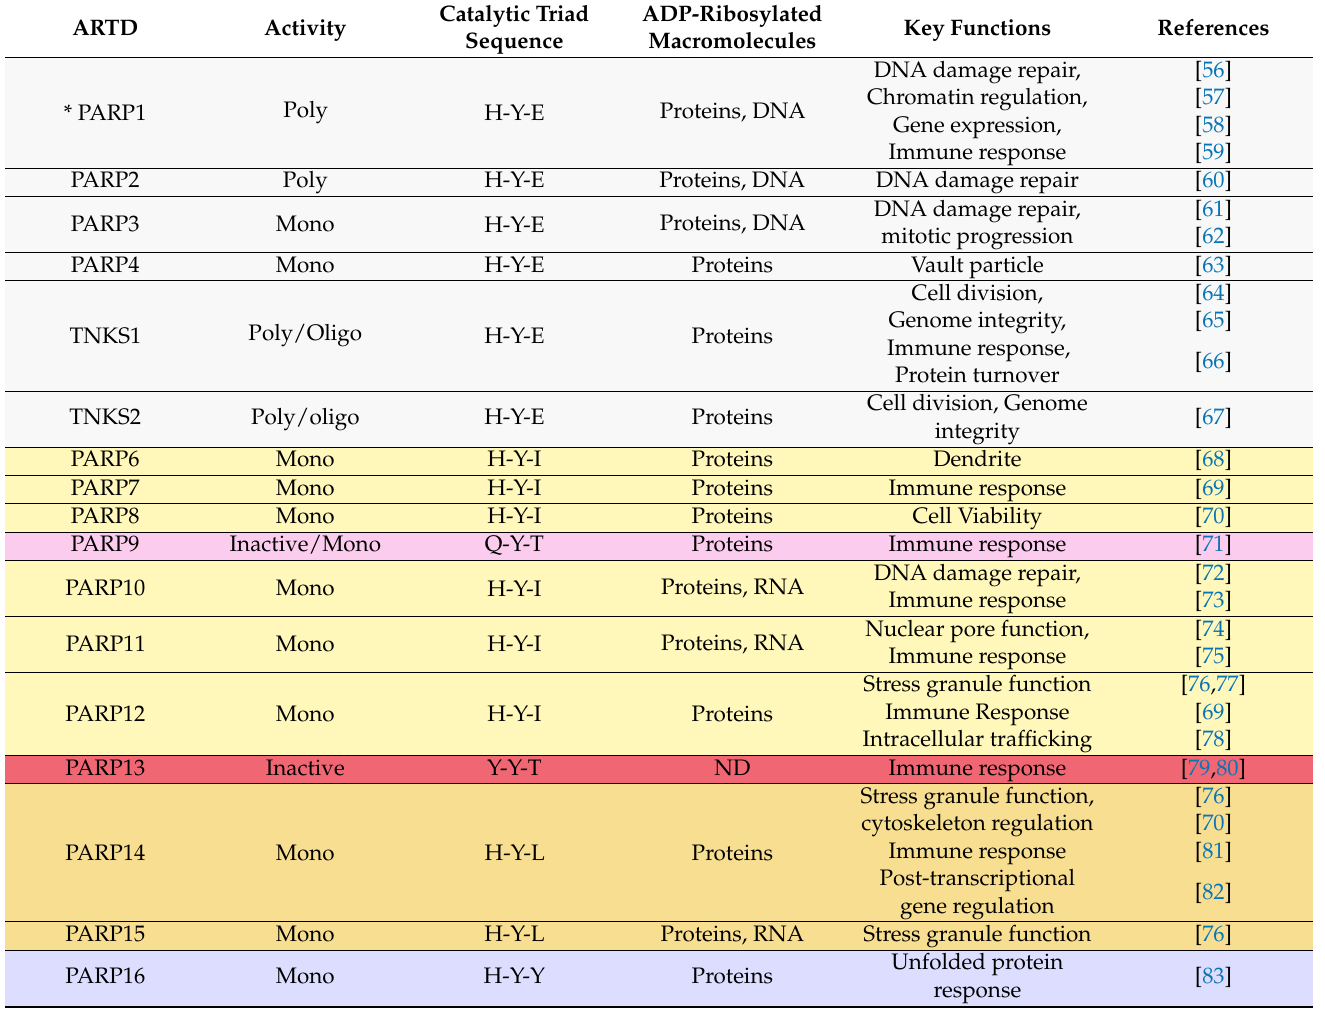
Table 1. Summary of the main features of ARTD family members showing the catalyzed enzymatic activity and the related biological processes in which they are